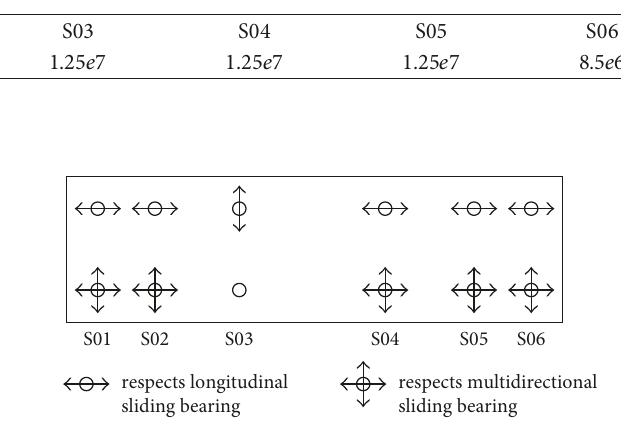
Table 3: Support reaction R of S01 ∼ S06 piers bearings.